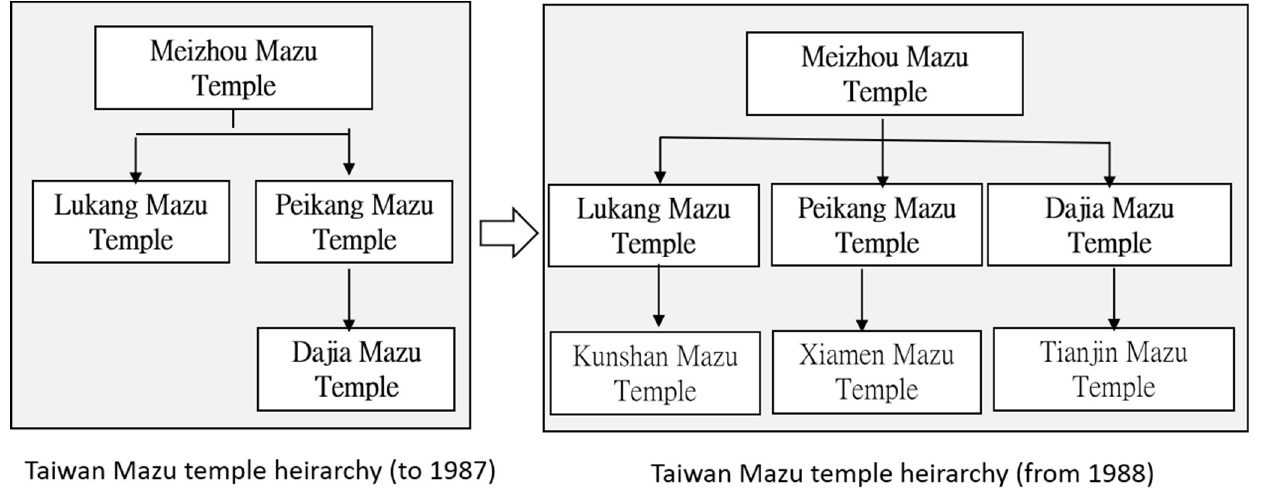
Figure 4. Change in Taiwan Mazu temples after pilgrimages/returns to ancestral home. Source: Compiled by the author.